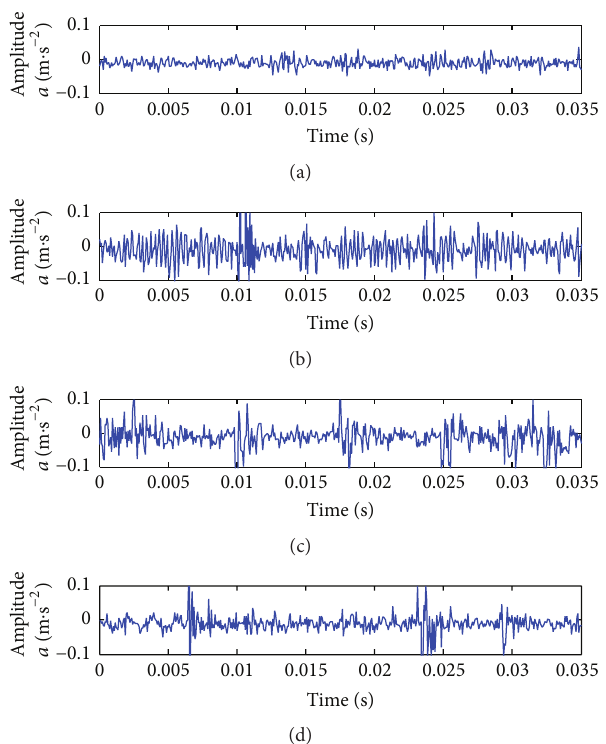
Figure 6: Instantaneous amplitudes waveform of rolling bearing in different conditions: (a) normal; (b) inner race fault; (c) outer race fault; (d) ball